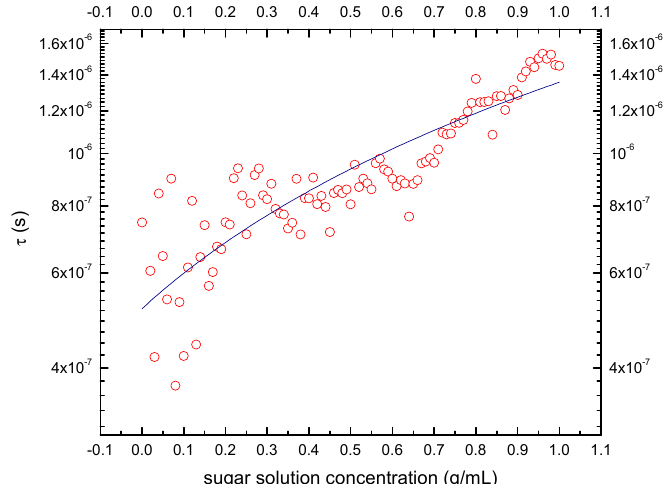
Figure 7. Relaxation time ( τ ) as a function of concentration from maxima peak in tan δ .